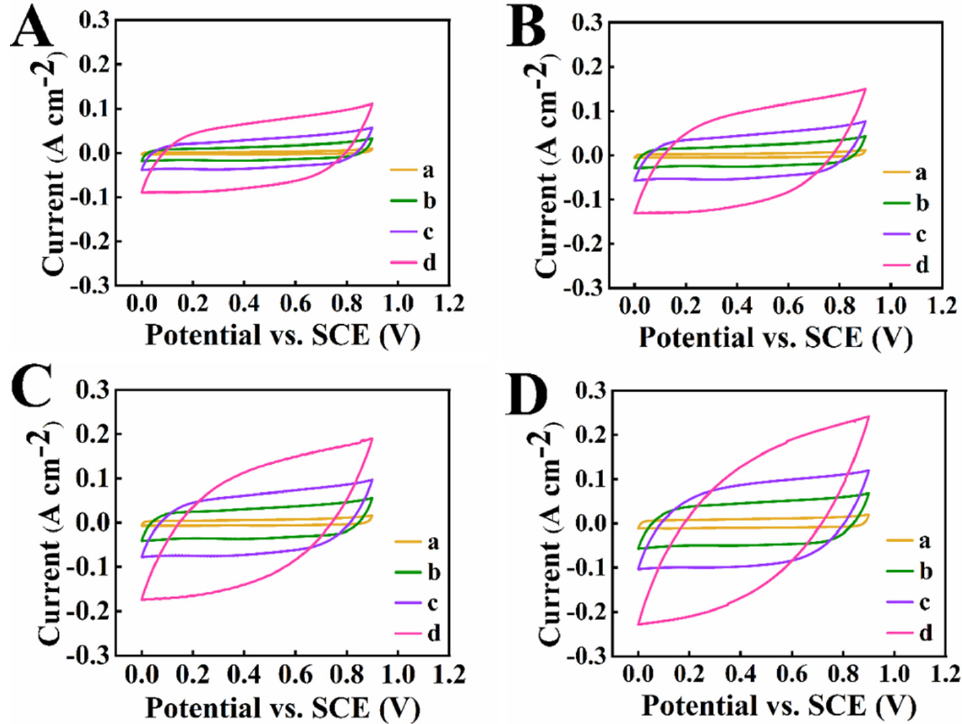
Figure 4. CVs for electrodes, prepared by method 1 for ( A ) TP 1, ( B ) TP 2, ( C ) TP 3 and ( D ) TP 5 at scan rates of (a) 2, (b) 10, (c) 20 and (d) 50 mV s − 1 .